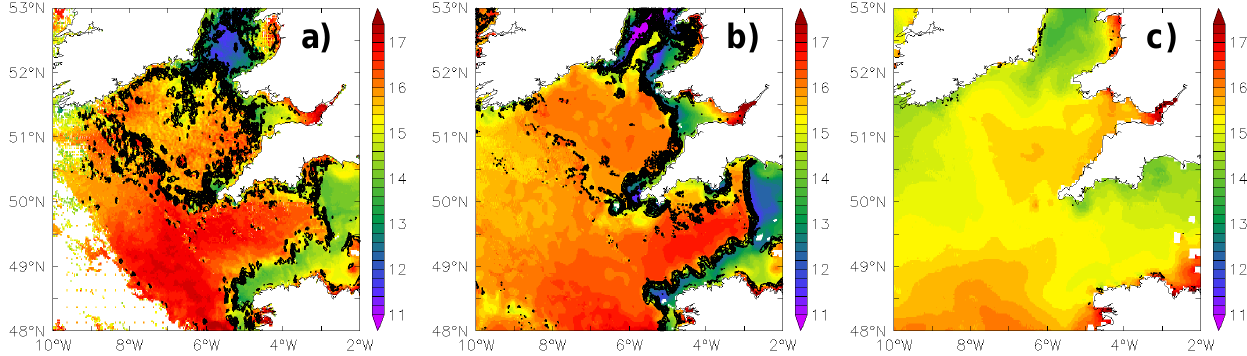
Figure 9 : Sea surface temperature (°C) on 24 th June with maximum horizontal gradients of SST overlaid Fig. 9. Sea surface temperature ( ◦ C) on 24 June with maximum horizontal gradients of SST overlaid for observation (a) , V2 system (b) and for observation (a), V2 system (b) and V1 system (c). V1 system (c) .